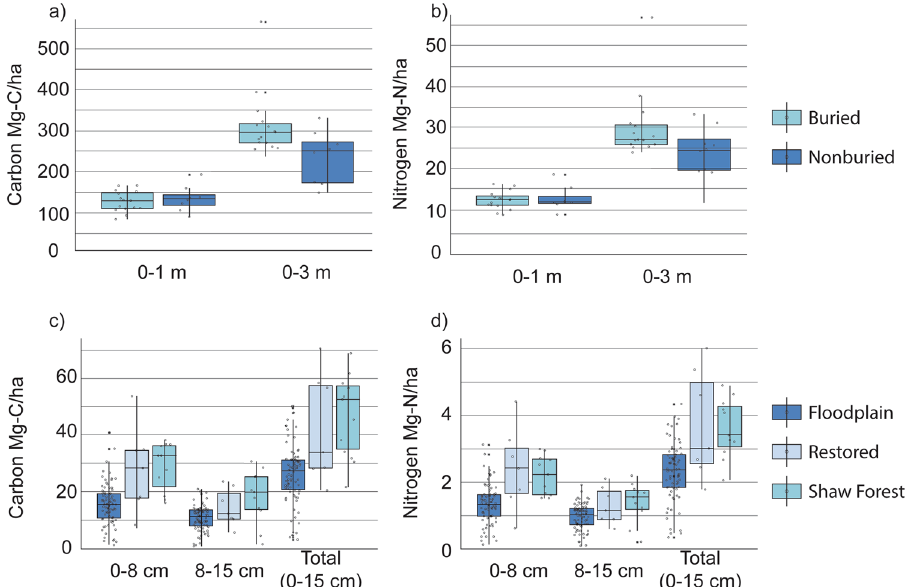
Figure 3. Box and whisker plots indicate the mean total C and N in Mg/ha for subsurface and surface samples. ( a , b ) Represent mean sums from 0–1 m and 0–3 m for subsurface soils with a buried horizon and subsurface soils without a buried horizon. ( c , d ) Represent mean sums from 0–8 cm, 8–15 cm and 0–15 cm for surface soils found in the Shaw forest, the floodplain and previously restored sites. Asterisks indicate outliers, whiskers indicate max and min values, the boxes represent the 25% and 75% quantiles and the hollow points are the discrete data points used to create the box